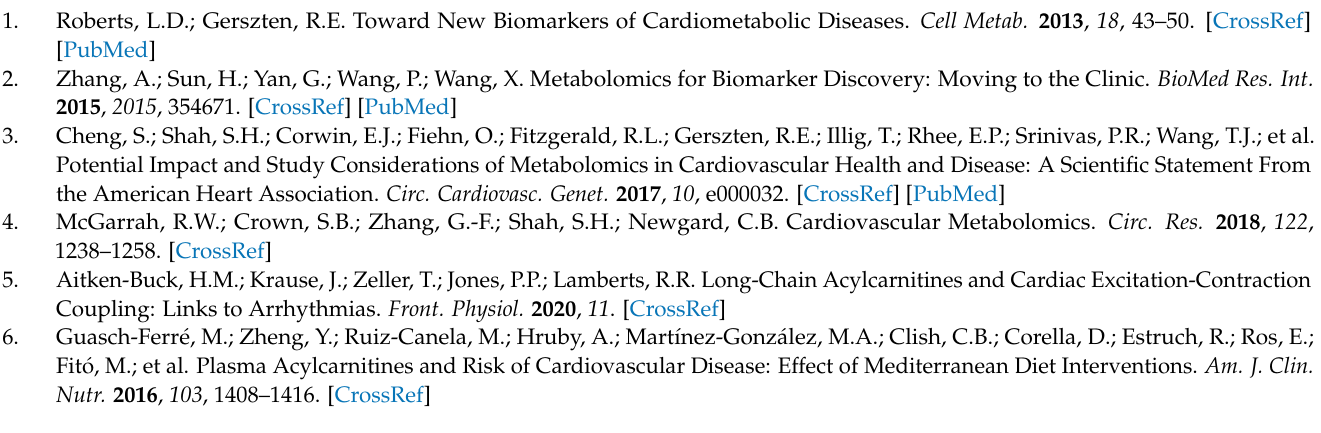
Supplementary Table S6. Acylcarnitines levels ( µ g/L) and SYNTAX Score groups; Supplementary Table S7. Acylcarnitine levels ( µ g/L) and SS metrics (heavy calcification and LVEF%); Supplementary Table S8. Linear regression for SYNTAX Score; Supplementary Table S9. Acylcarnitine levels ( µ g/L) comparison between kidney failure and non-kidney failure patients (GFR < 55); Supplementary Figure S4. Log10 scaled histogram of acylcarnitine levels comparison between kidney failure and non-kidney failure patients (GFR <